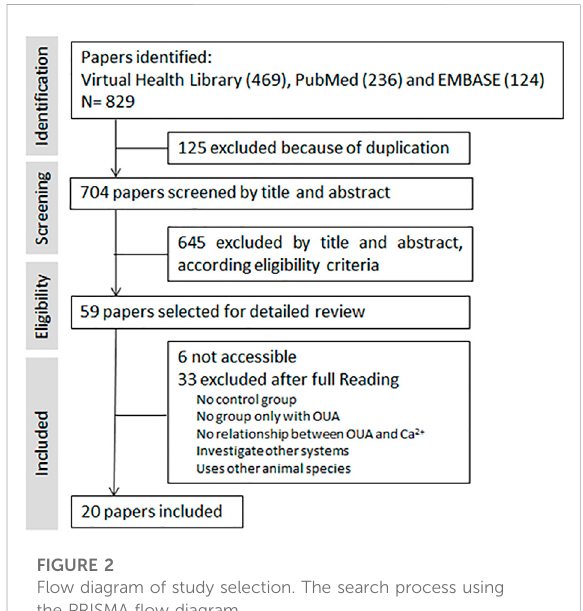
(Table 2). One study of the effects of ouabain in Ca 2+ signaling